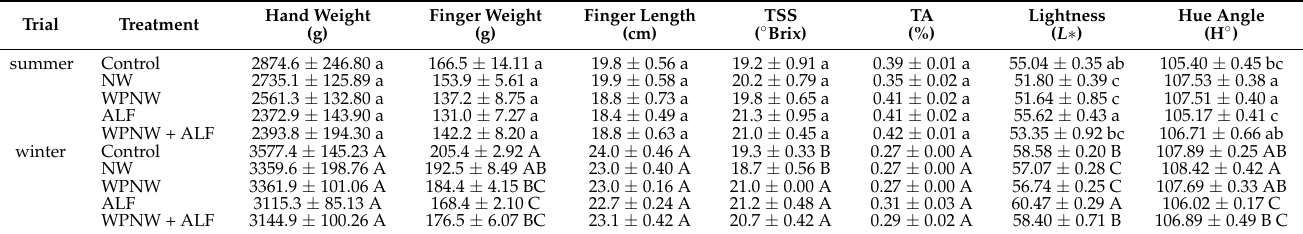
Note : Different letters in a column indicate significant differences at p < 0.05. Values are means ± SE from six replicates.